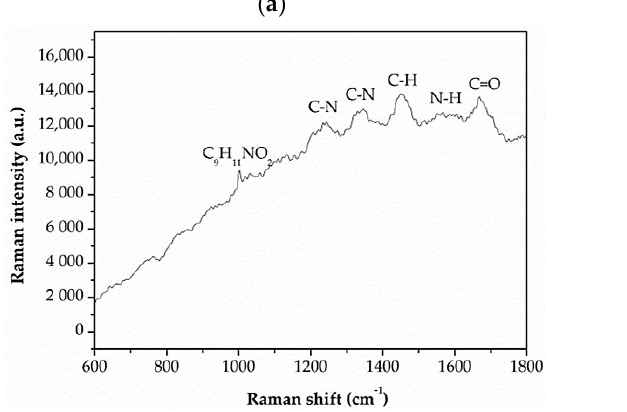
Figure 7. Raman spectra of the casein ( a ) and the casein coating deposited on MgCa2Zn1 ( b ).